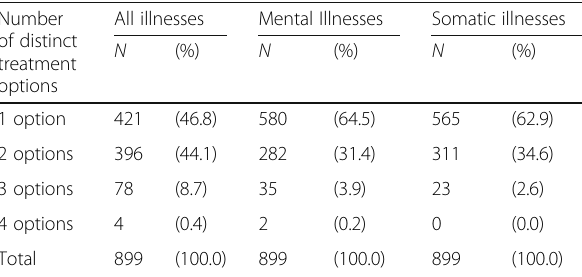
Table 2 Diversity of treatment options selected by the participants by type of illness Number of distinct treatment options